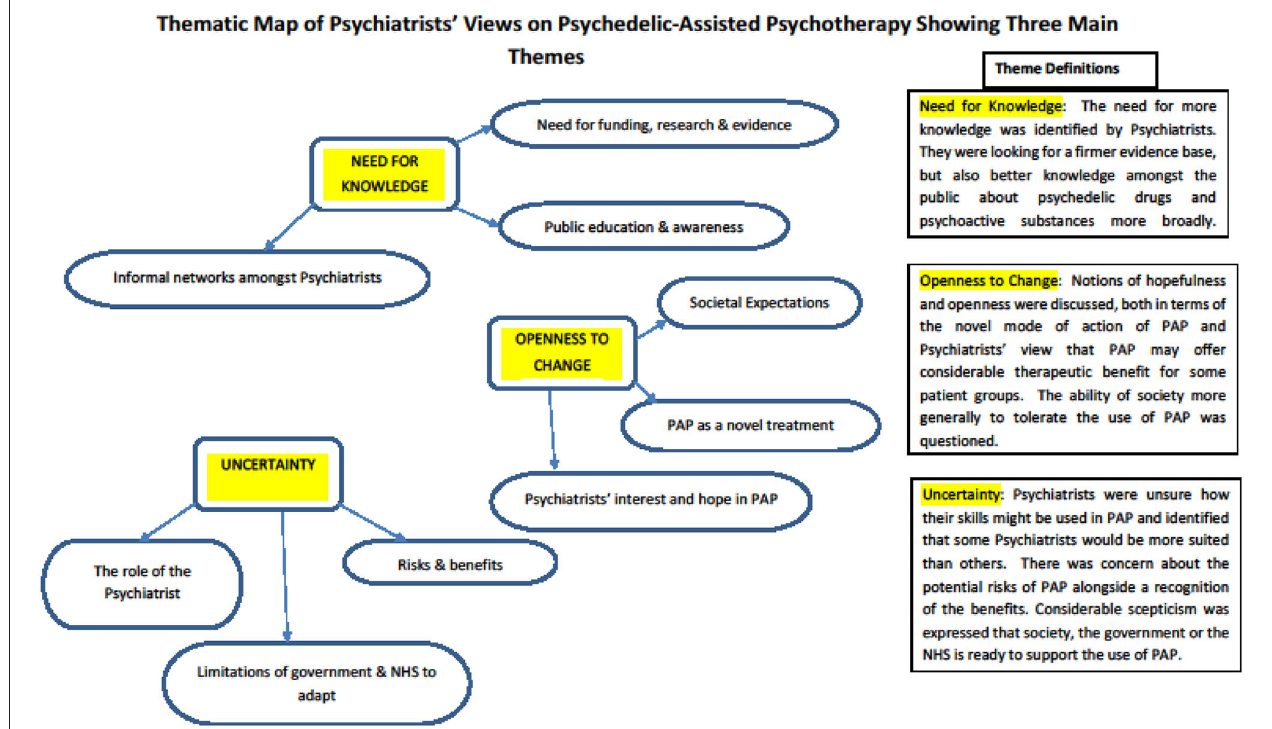
FIGURE 3 | Thematic map detailing the main themes and codes from the thematic analysis of focus groups held with Psychiatrists.